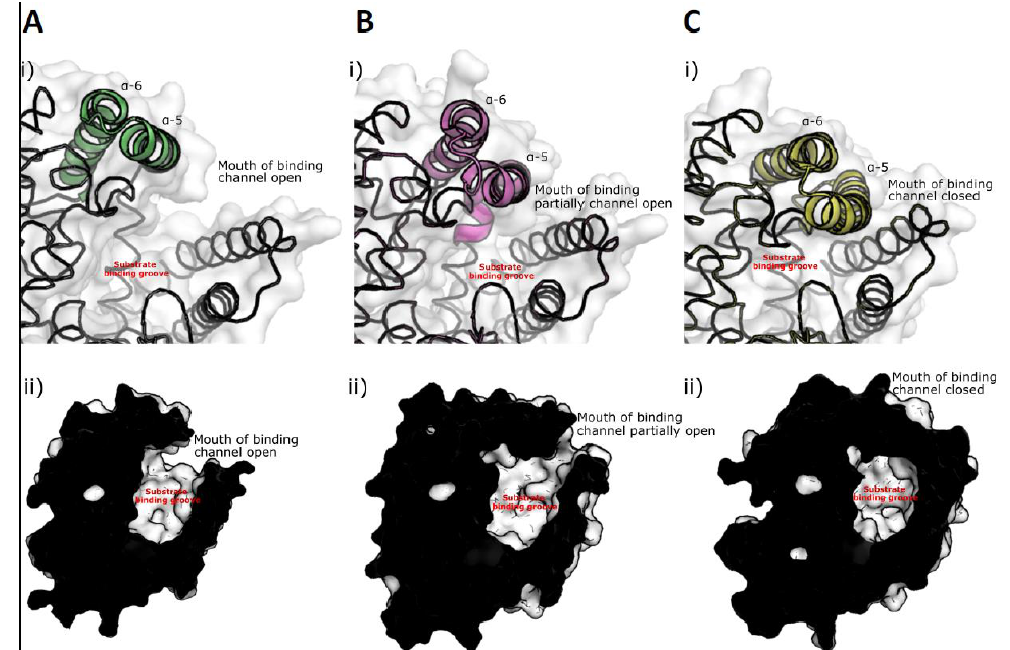
Figure 5. The opening of the mouth of the substrate binding channel in various structures of M32 Carboxypeptidases. (i) Shows the carton depiction of α-5 and α-6 (ii) shows a cross section through the surface representation. ( A ): PDB of ChtCP (PDB: 7A03), ( B ): PDB: 3HOA (r.m.s.d = 1.19 Angstrom), ( C ): PDB: 3HQ2 (r.m.s.d = 1.927 Angstrom).